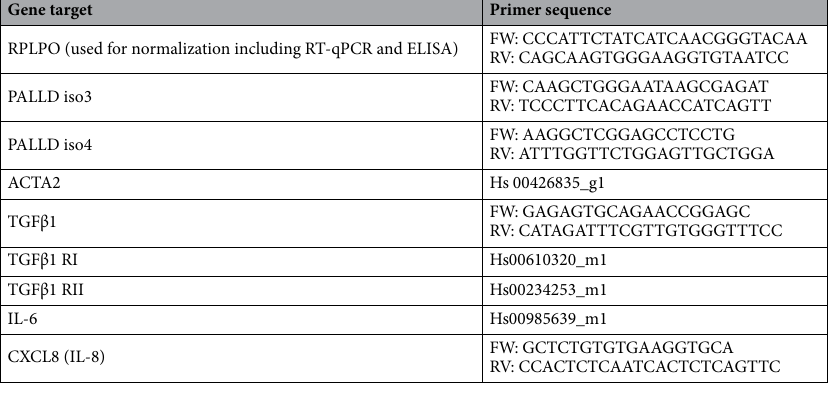
Table 4. List of RNA